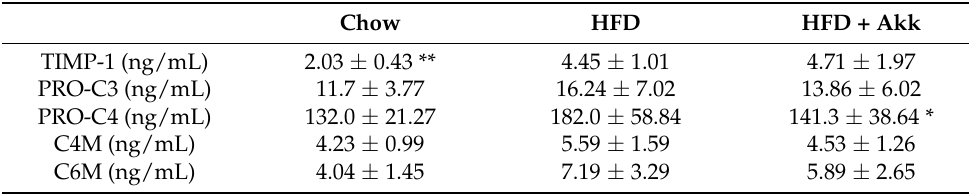
Table 4. Serum concentrations of extracellular matrix turnover